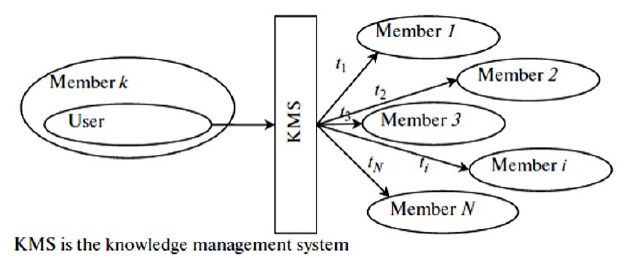
Fig. 7. Interaction without context orientation.